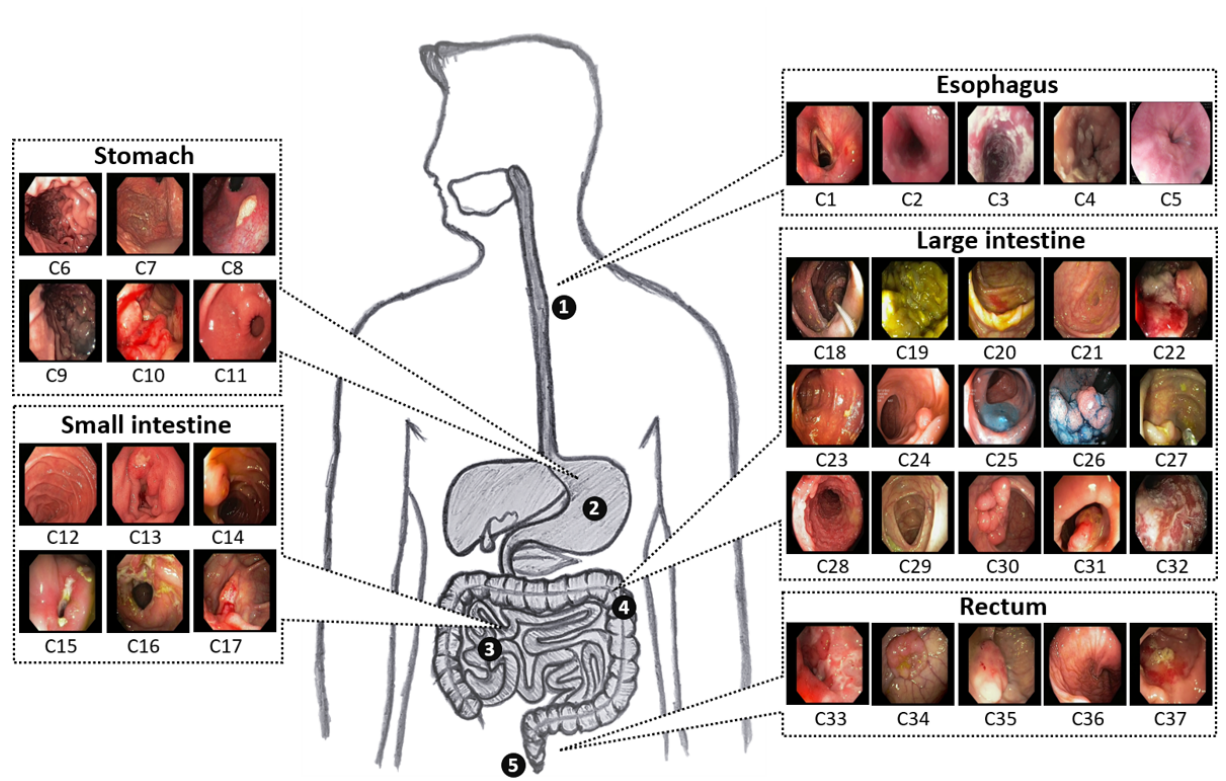
Figure 3. Example frames of our selected data set for each class and their correspondence with the different anatomical districts of the human gastrointestinal